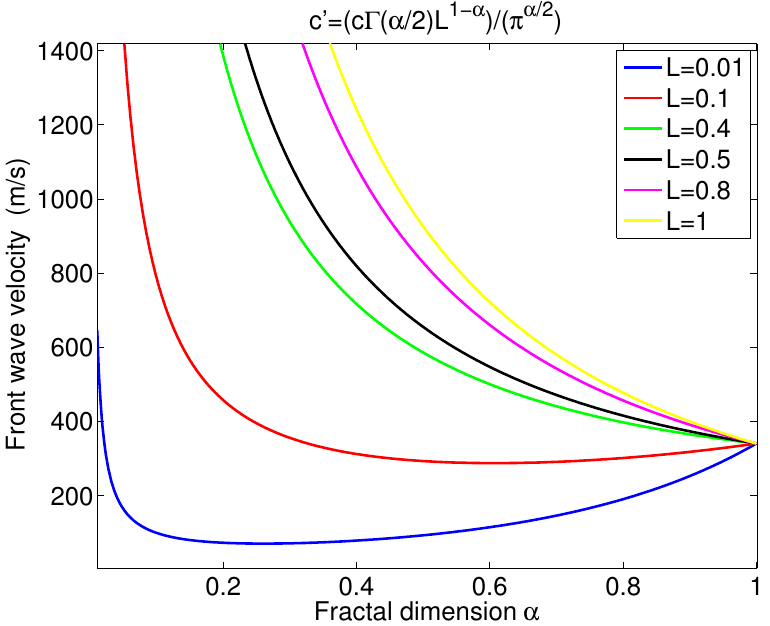
Figure 3. Variation of the front wave velocity in the fractal material as a function of the fractal